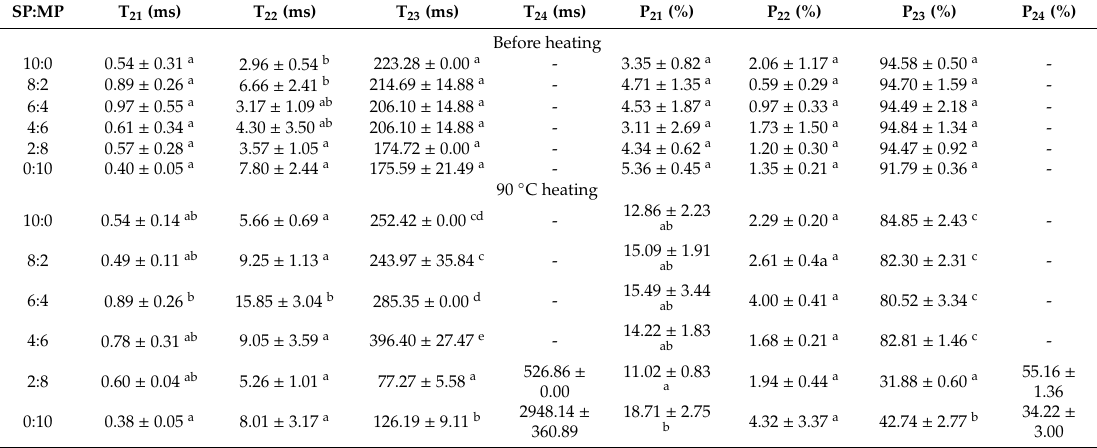
Table 1. Low field nuclear magnetic resonance (LF-NMR) parameters of T 2 relaxation times and peak area (P) of the dual-protein system with various SP / MP proportions before and after 90 ◦ C heating for